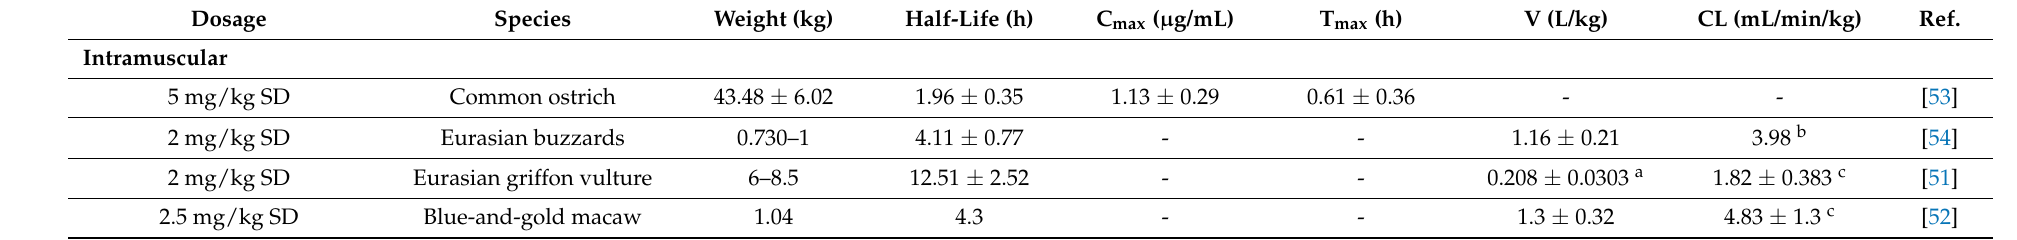
Table 5. Pharmacokinetic values for marbofloxacin in exotic avian